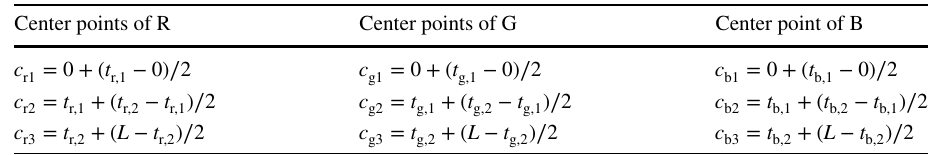
Table 3 Center points of color components